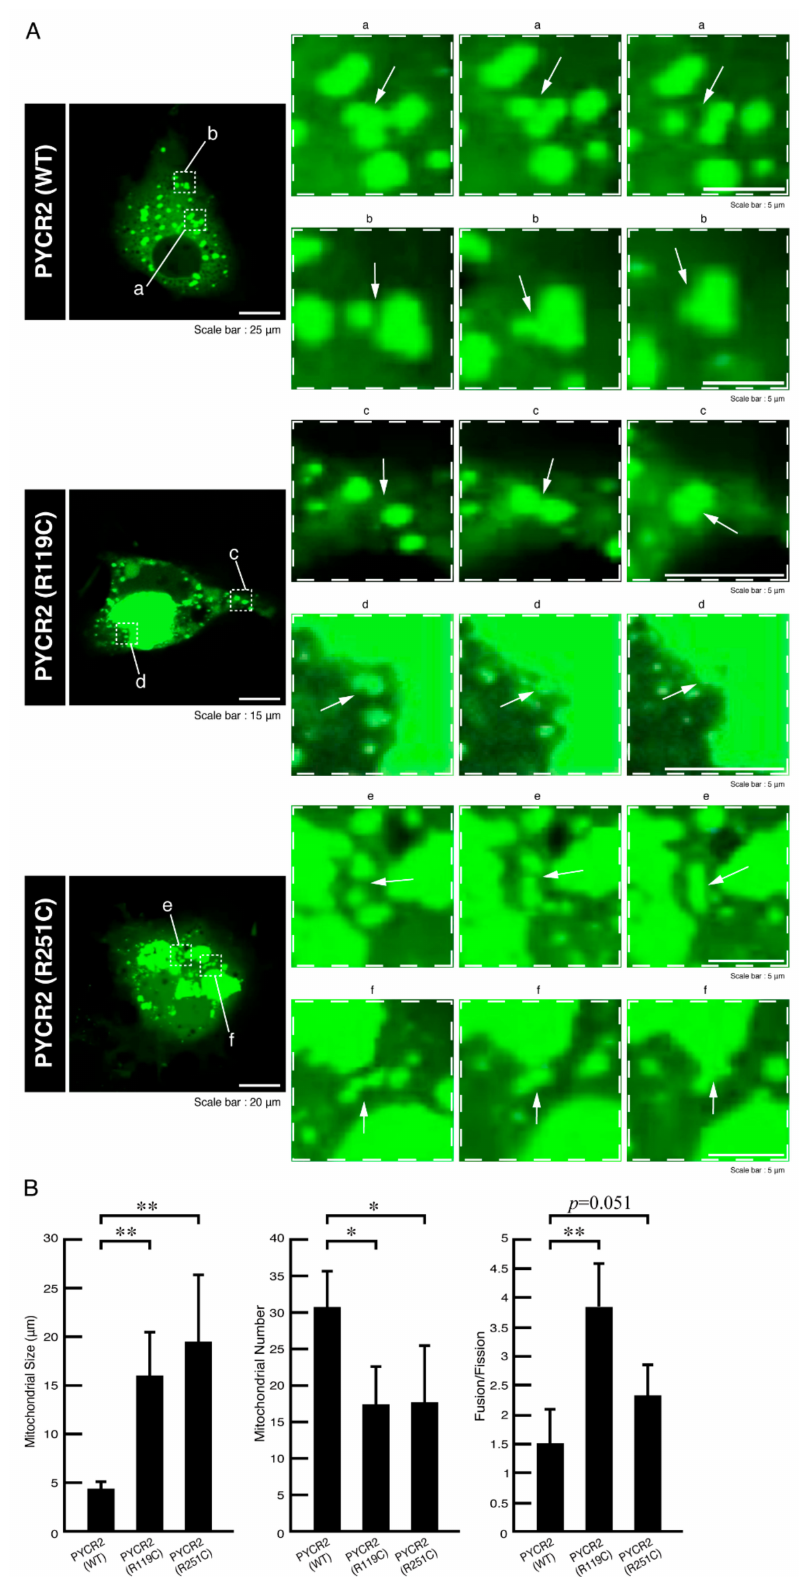
Figure 5. The R119C or R251C proteins preferentially increase mitochondrial fusion whereas the wild type ones exhibit normal size mitochondoria. ( A ) COS-7 cells were transfected with the plasmid